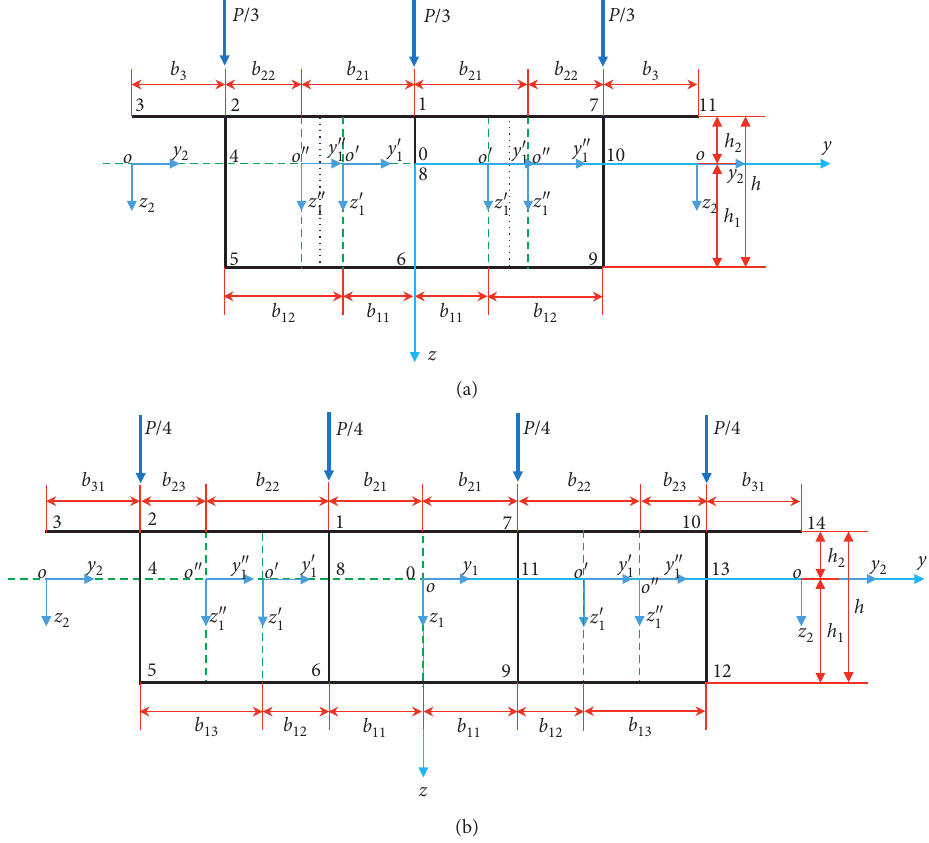
Figure 1: Cross section of the multicell box girder: (a) single-box two-cell (1B2C) ( ζ � 2); (b) single-box three-cell (1B3C) ( ζ �